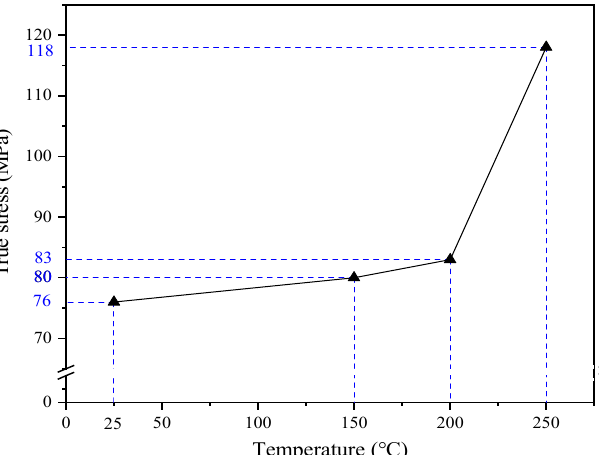
Figure 5. The deviation value of true stress on the true strain of 0.2 at different tensile temperatures.